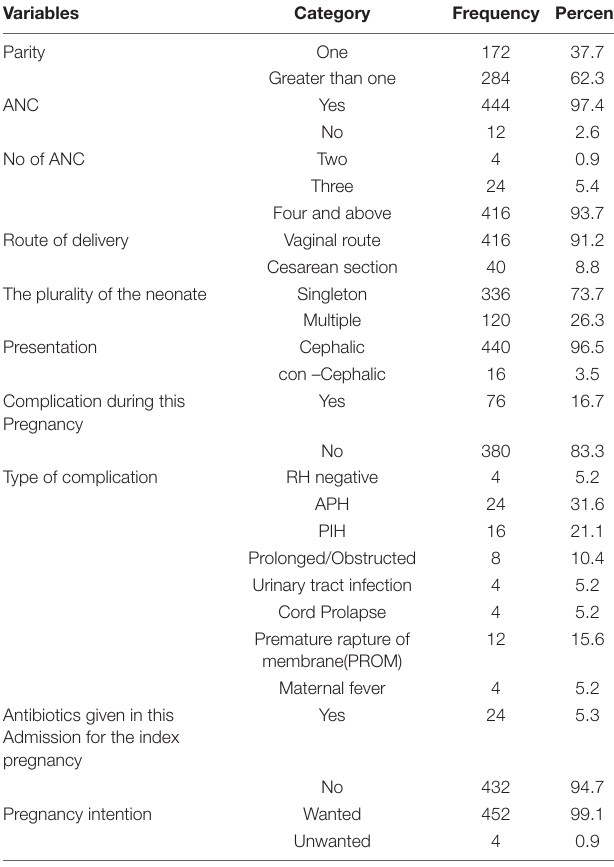
TABLE 1 | Maternal socio-demographic characteristics in south Gondar zone public hospitals, northwest Ethiopia, 2021. Variable Category